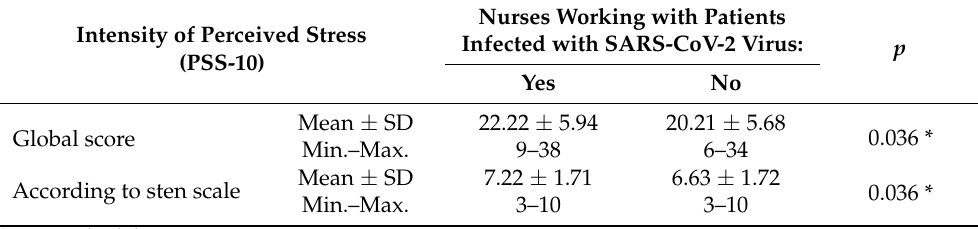
Table 2. Intensity of perceived stress in nurses working with patients infected and those working with patients not infected with the SARS-CoV-2 virus. Nurses Working with Patients Intensity of Perceived Stress Infected with SARS-CoV-2 Virus: p (PSS-10) Yes No Mean ± SD 22.22 ± 5.94 20.21 ± 5.68 0.036 * Global score Min.–Max. 9–38 6–34 Mean ± SD 7.22 ± 1.71 6.63 ± 1.72 According to sten scale 0.036 * Min.–Max. 3–10 3–10 SD—standard deviation, Min.—minimum, Max.—maximum, * p <